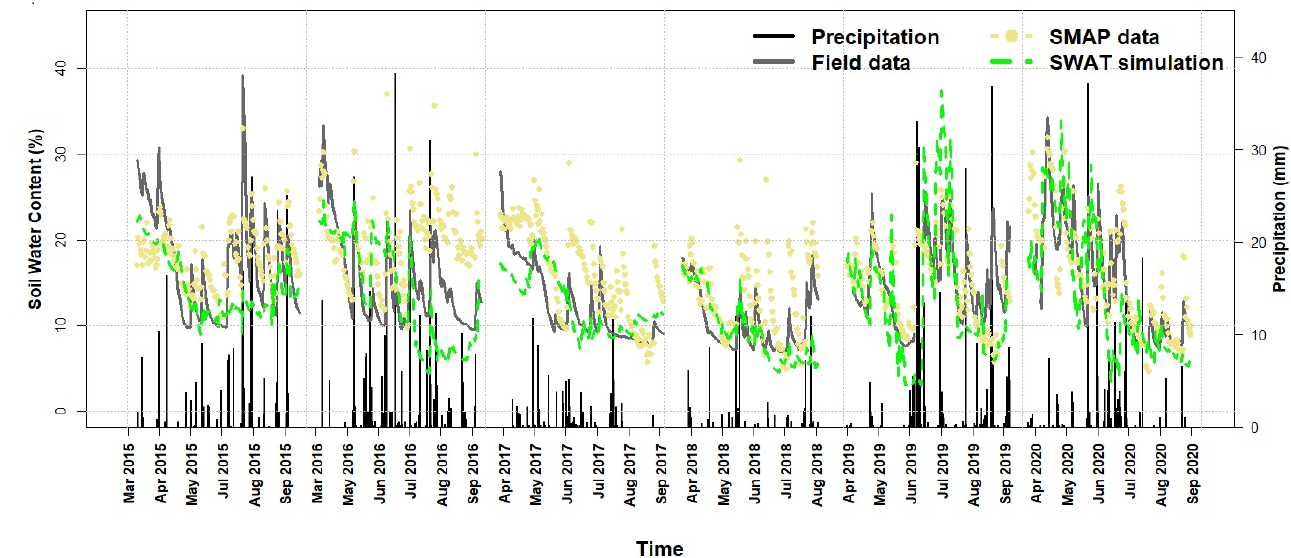
Figure 4. Temporal comparison of soil water content.